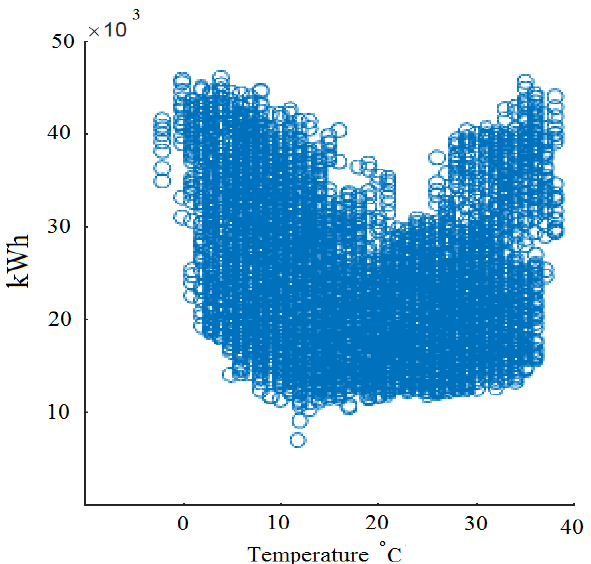
Figure 8. Scatter plot of hourly demand vs. temperature in Jordan (Madaba).